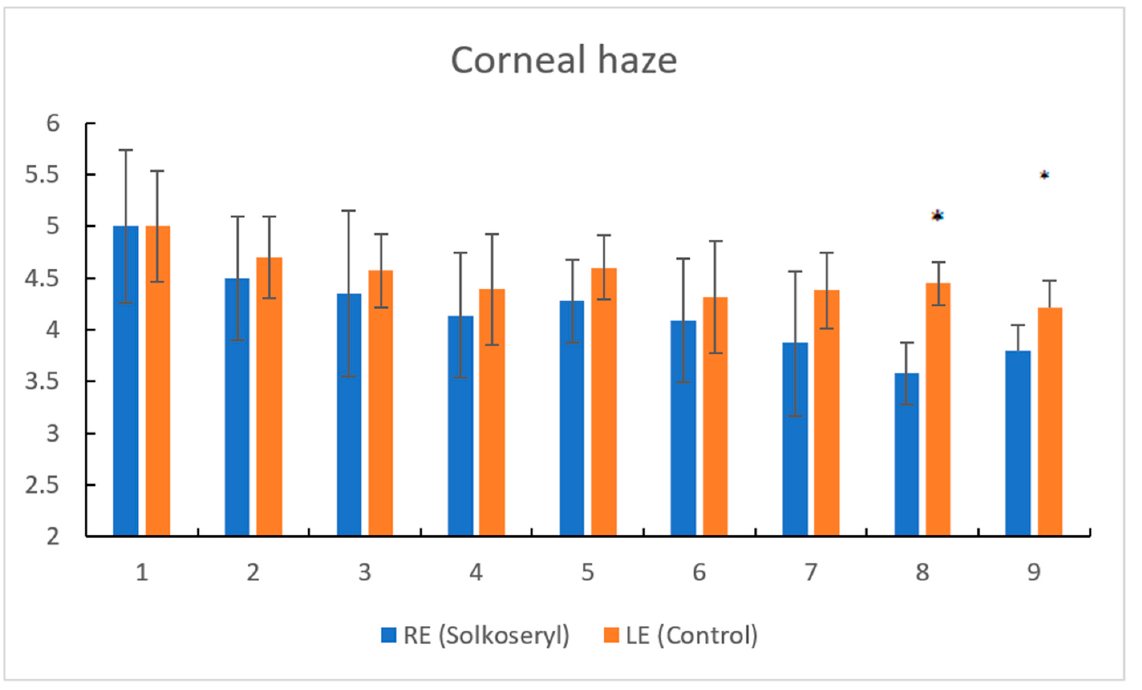
Figure 3. Corneal damage scores ( Y -axis) from the start of the experiment to week 9, on a five-point scale (1—cornea completely clear and 5—cornea completely opaque) in the Solcoseryl-treated group compared to controls. Observations were made at 9 weeks ( X -axis). RE—right eye, LE—left eye. *—statistically significant. Number of eyes: 24.